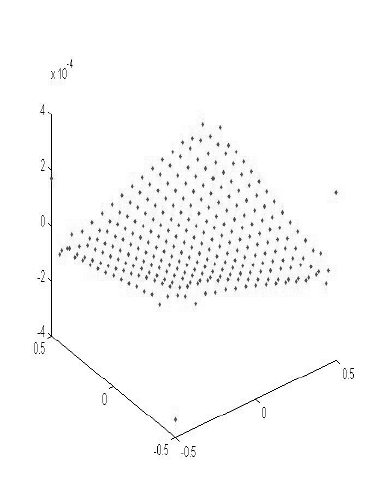
Figure 1. Difference between exact and computed pressure, τ = h = 0 . 0156 and T = 1 . 57.